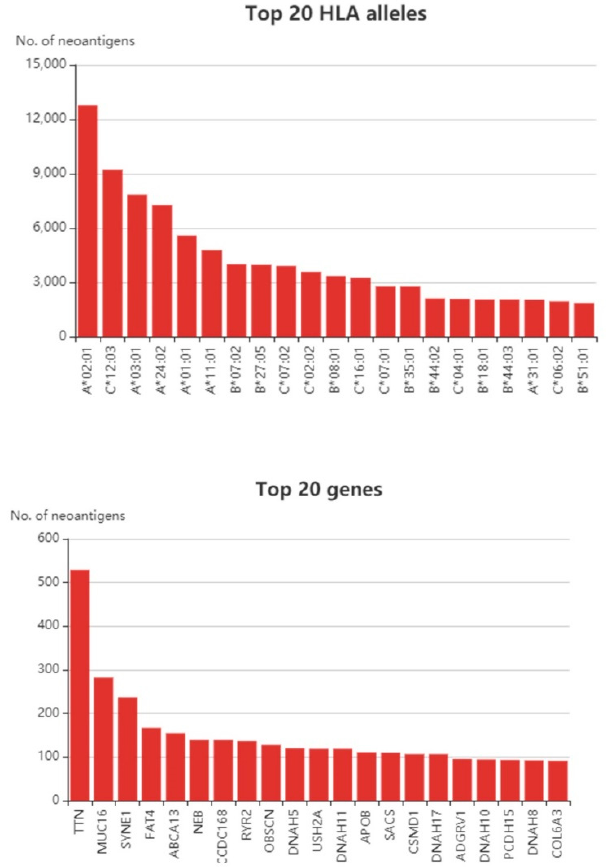
Figure 1. Top 20 human leukocyte antigen (HLA) alleles and top 20 neoantigen-producing genes in colorectal cancer (CRC) samples from the Cancer Genome Atlas (TCGA) cohort. Data obtained from the TSNAdb database [60].